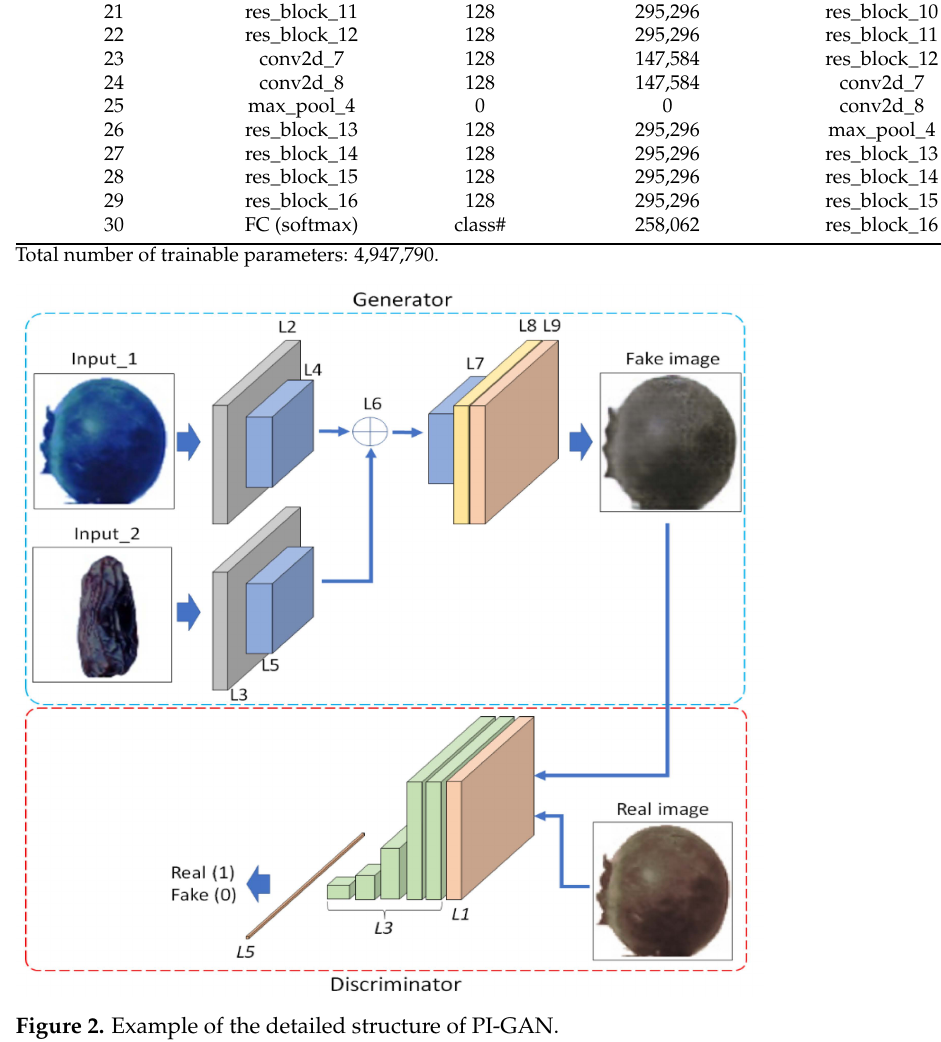
Figure 2. Example of the detailed structure of PI-GAN.